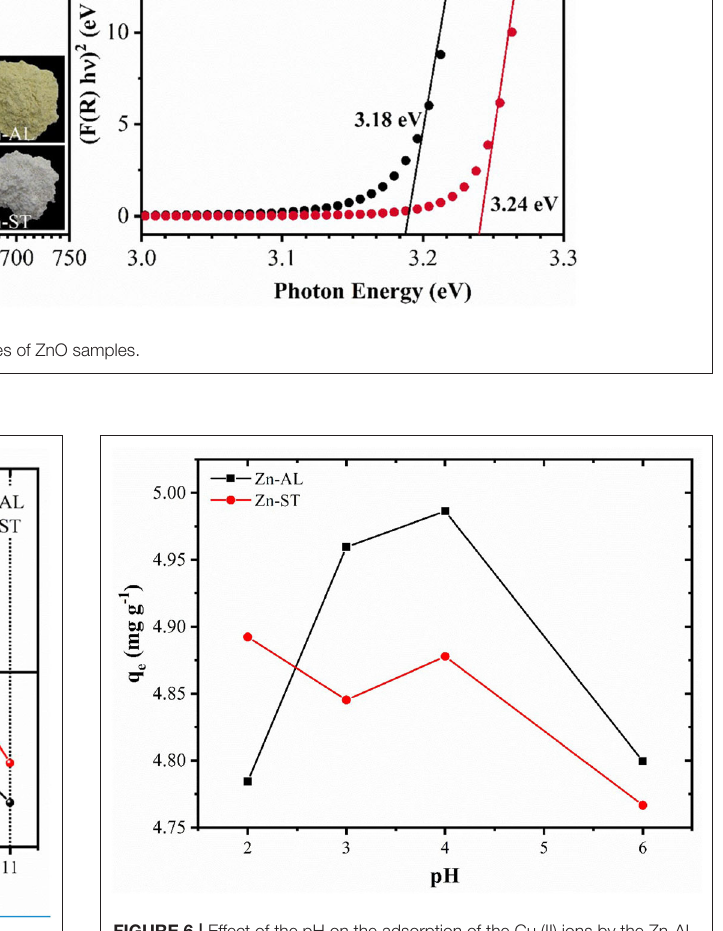
FIGURE 5 | Zeta potential as a function of pH and point of zero charge (pH PZC ) for the Zn-AL and Zn-ST samples.